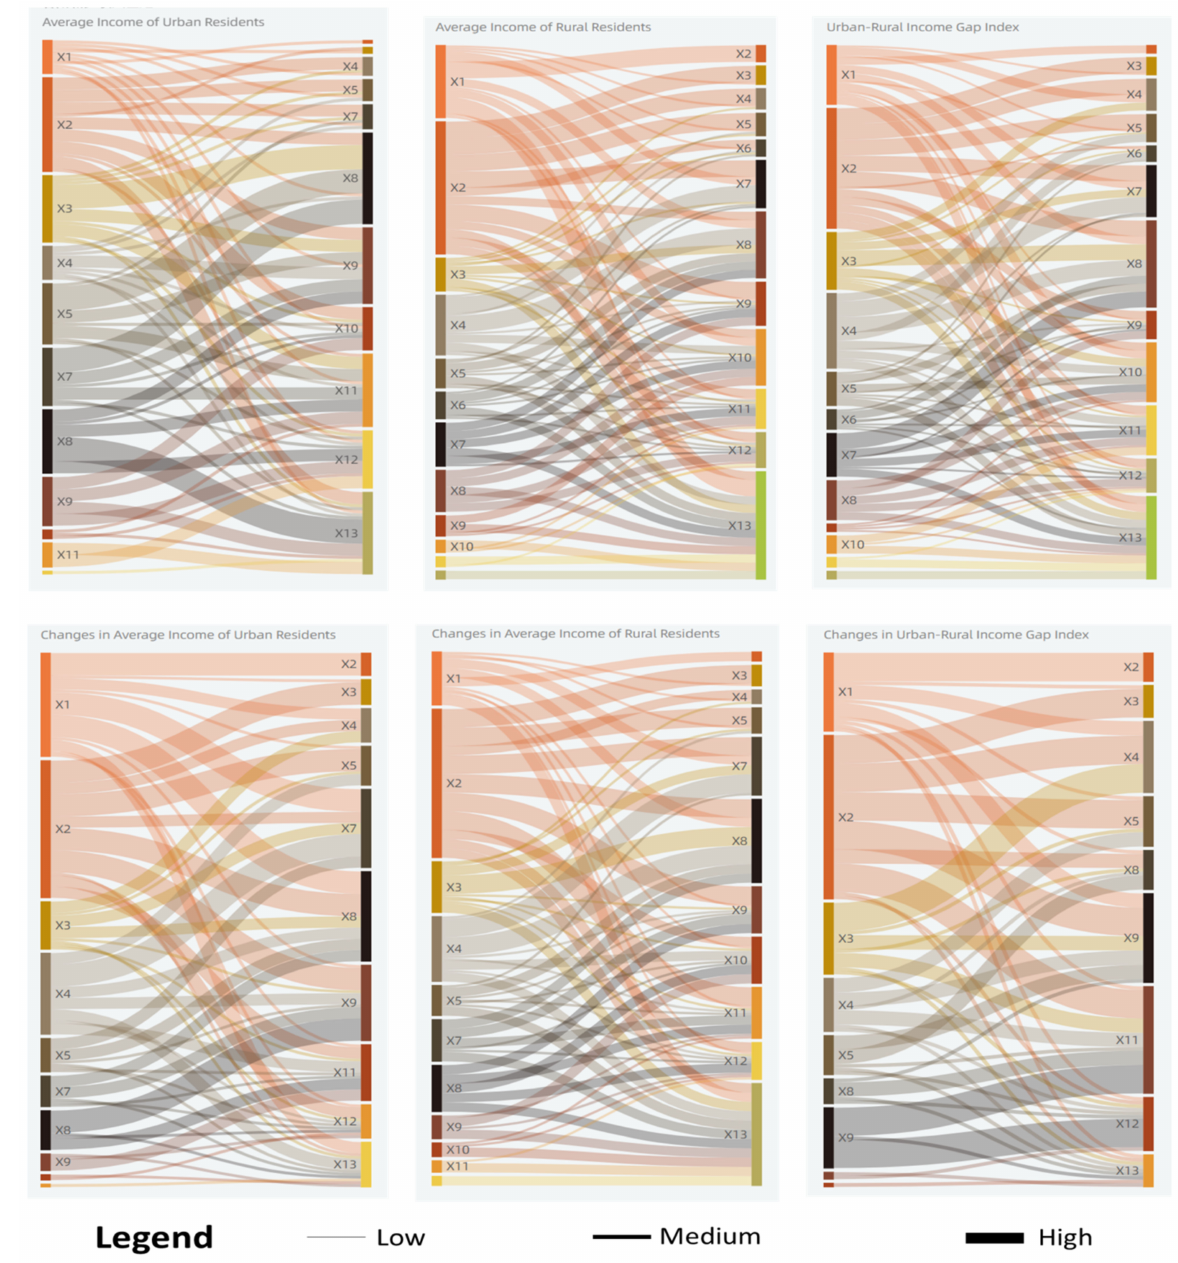
Figure 11. Analysis of interaction